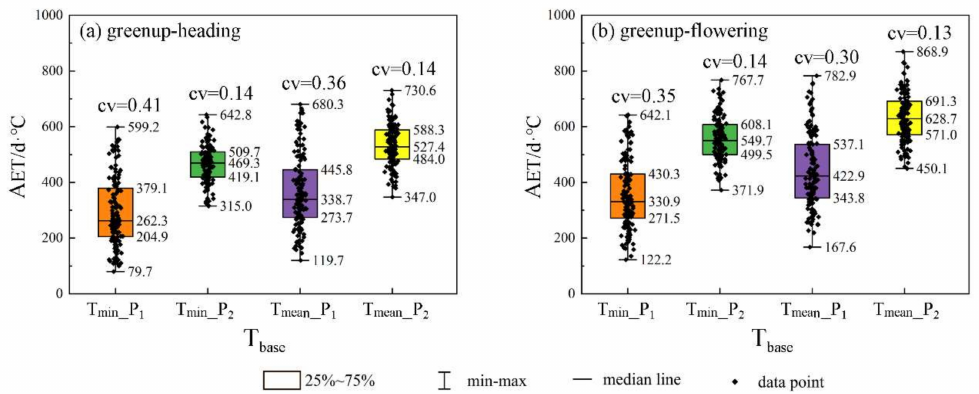
Figure 2. Boxplot of accumulated e ff ective temperature (AET) from observed green-up date to heading date ( a ) and flowering date ( b ) based on di ff erent T base . T min _P 1 : the average of daily minimum